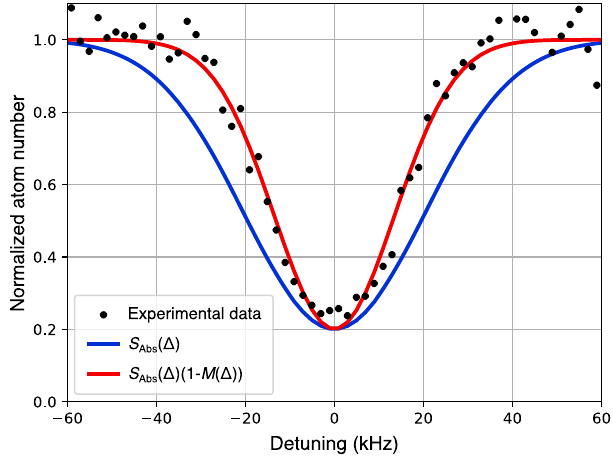
Fig. 3 | Comparison of the observed spectrum to the models. The measured spectrum (black dots) is plotted together with the calculated Doppler broadened pro fi le (solid blue line) and the narrowed pro fi le based on Pauli-blocking when no depumper light is present (solid red line). Each data point is followed by a back- ground shot for which no probe light is present, and a polynomial fi t to the tem- poralevolutionofthebackgroundisusedforthenormalizationof theshowndata. Wedidnotadderrorbarstothedatapointsastheywouldonlyre fl ecttheaccuracy with which the number of atoms can be determined from a time-of- fl ight pro fi le, butnotberepresentativeofthestatisticsoftheexperiment,whichcanbeobserved as the 10 to 15% scatter between individual points.